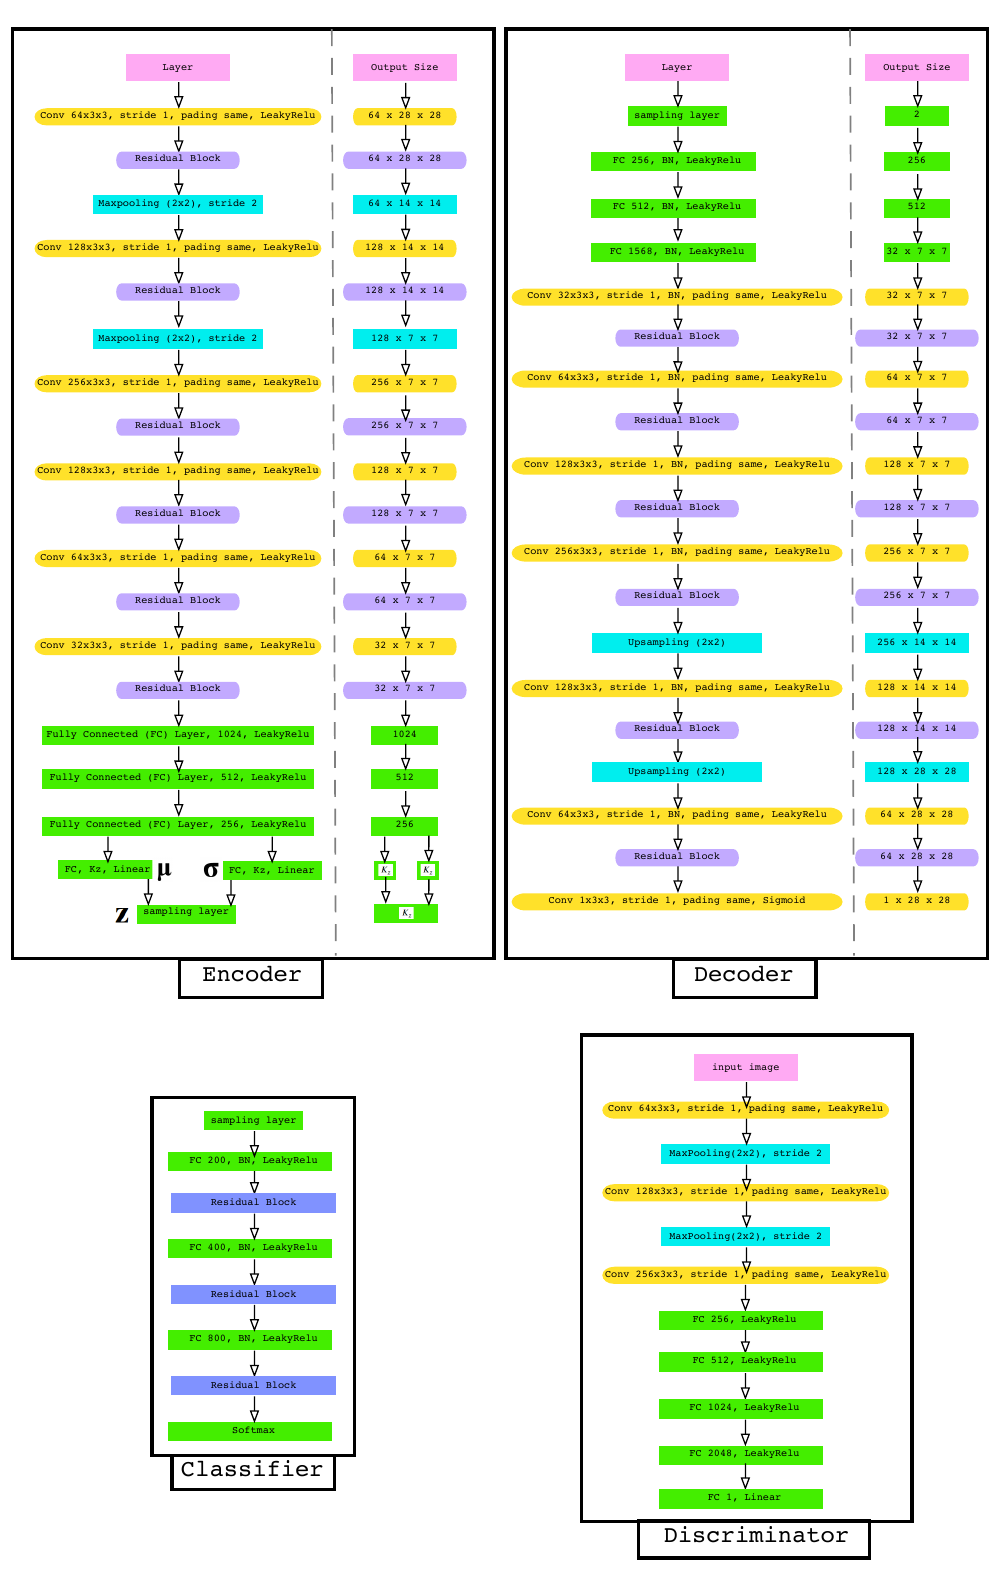
Figure 6. The architecture of the encoder, decoder, discriminator and the classifier. For the decoder, we almost used the inverse encoder structure. The input of the decoder is the sampling layer followed by three fully connected layers with batch normalization and